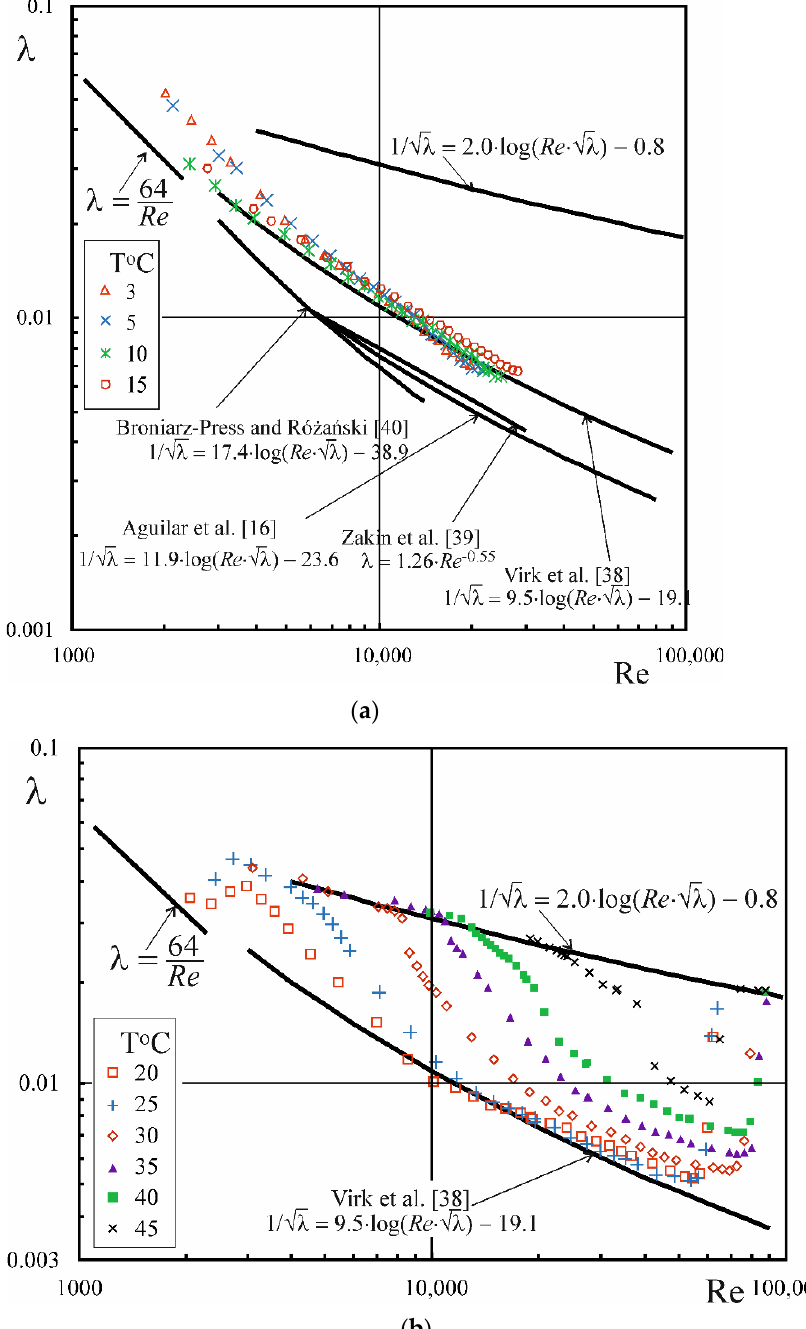
Figure 3. Friction factor versus solvent Reynolds number for CAPB/DEA solutions (0.09%/0.075%; D = 11.1 mm) in the range of temperature from 3 to 15 ◦ C ( a ) and from 20 to 45 ◦ C ( b ). The rise in temperature to 20 ◦ C causes a characteristic inflection visible on the λ = f( Re ) curve above Re = 2300, which demonstrates the emergence of the transitional flow